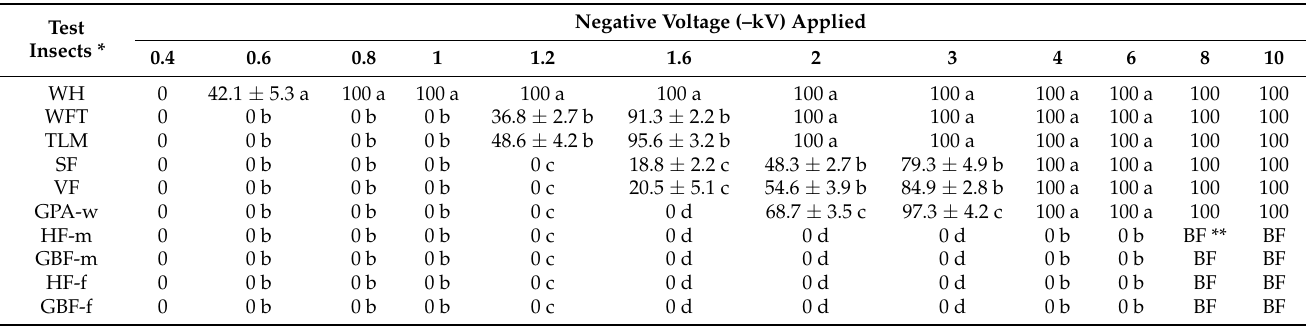
Table 1. Percentage of insects captured by an experimental instrument consisting of a negatively charged insulated conductor (iron) plate (NIP) and a grounded non-insulated conductor plate (GCP) at a separation interval of 5 mm.